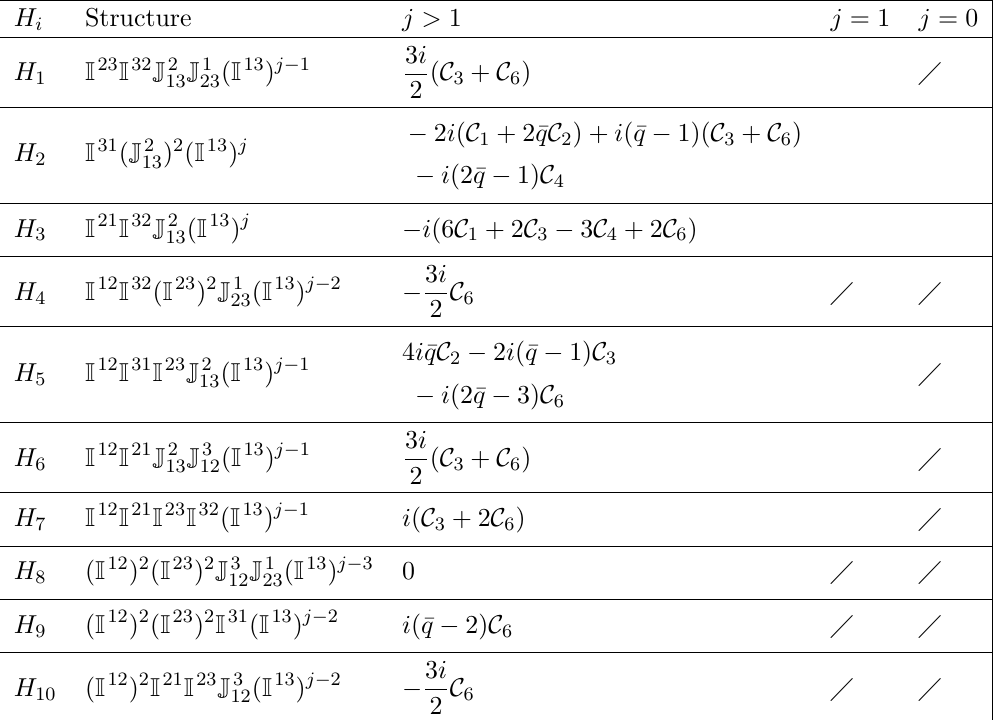
( QO ) T ( QO ) when QO h i